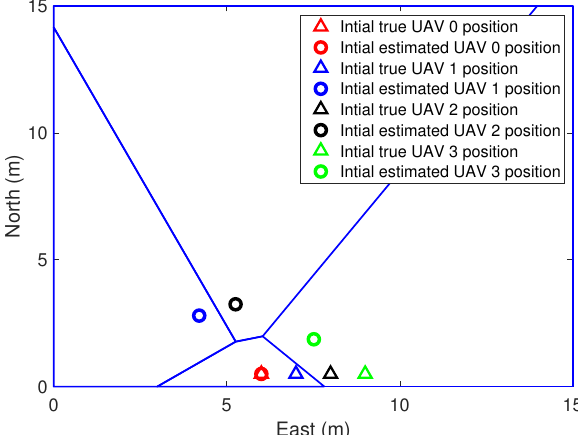
Figure 3. The process of coverage task performing, k = 0 s.